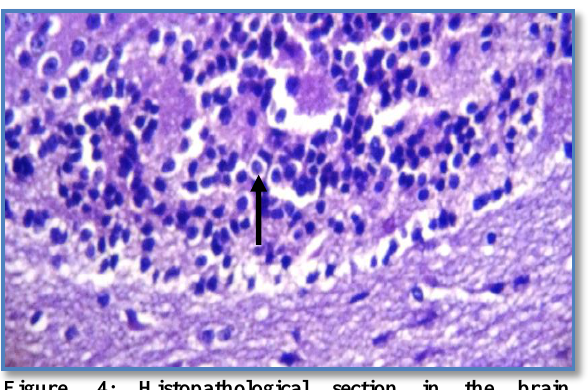
Figure, 4: Histopathological section in the brain (cerebrum) of mice injected I/P with 0.1ml of suspension of digested organs at day 21 showing diffuse gliosis of the submeningeal tissue ( ) H and E 40x.